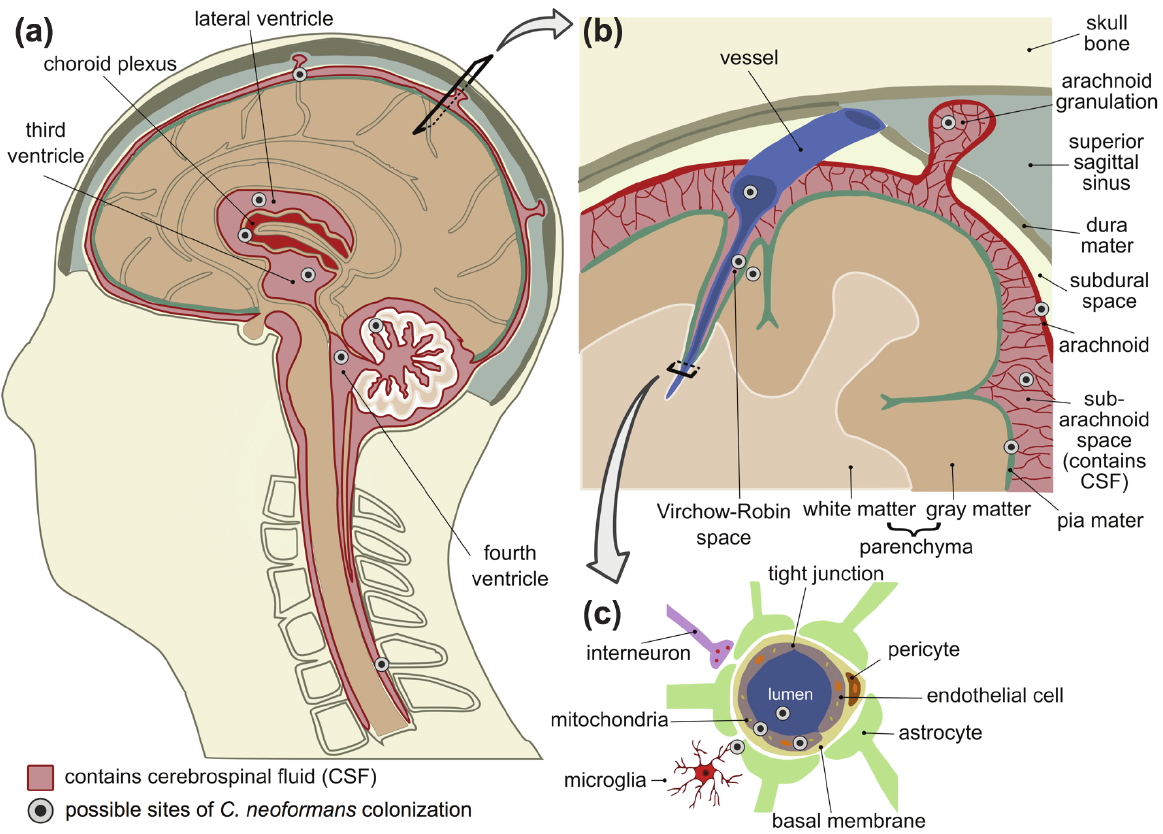
Fig. 3 - General view of the brain anatomy and areas affected by C. neoformans . a . Brain sagittal section and structures associated with the CSF. b . Coronal section of skull, meninges and parenchyma. c . Transversal section of the brain capillary and structural organization of the blood-brain